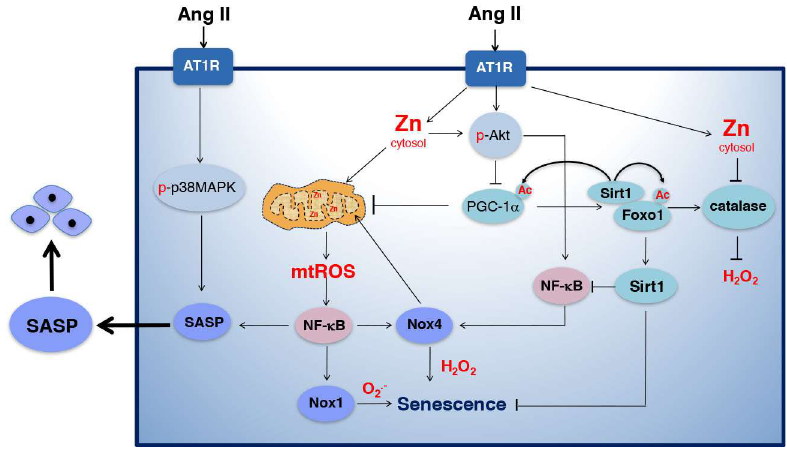
Figure 2. The role of Ang II in vascular senescence. Ang II binding to AT 1 R activates signal transduction pathways, including phosphorylation of p38MAPK, a driver of the SASP, and Akt, a negative regulator of PGC-1 α function. Akt phosphorylates PGC-1 α, increasing its acetylation, which reduces the binding of PGC-1 α /FoxO1 (forkhead box O 1) to catalase and Sirt1(silence information regulator 2-like 1) promoters, reducing the expression of these target genes. Reduced Sirt1 expression further increases PGC-1 α and FoxO1 acetylation, creating a negative feedback loop. Ang II also increases cytosolic zinc levels, leading to mitochondrial zinc accumulation that causes mitochondrial dysfunction and mitochondrial ROS (MitoROS) production that mediates NF- κ B activation and Nox1 expression. NF- κ B drives the SASP, and also mediates Nox4 upregulation and oxidative stress. Sirt1 inhibits senescence by deacetylating NF- κ B, PGC-1 α and FoxO1, thus improving mitochondrial function and the antioxidant capacity, while zinc induces senescence by causing mitochondrial dysfunction, increasing Nox1 and reducing catalase expression. SASP stimulates senescence in bystander cells.